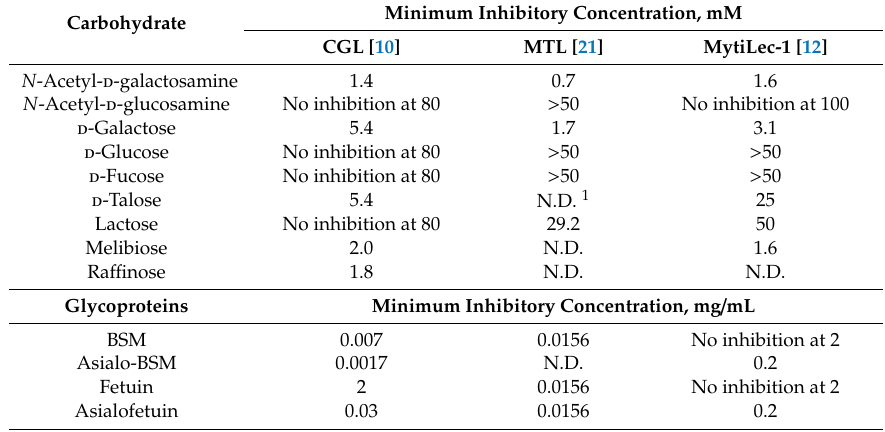
Table 2. Carbohydrate specificity of CGL, MTL, and